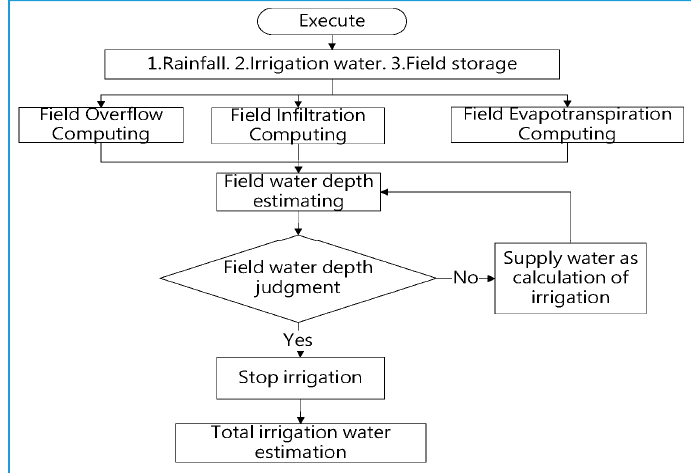
Figure 11. Model flow diagram.